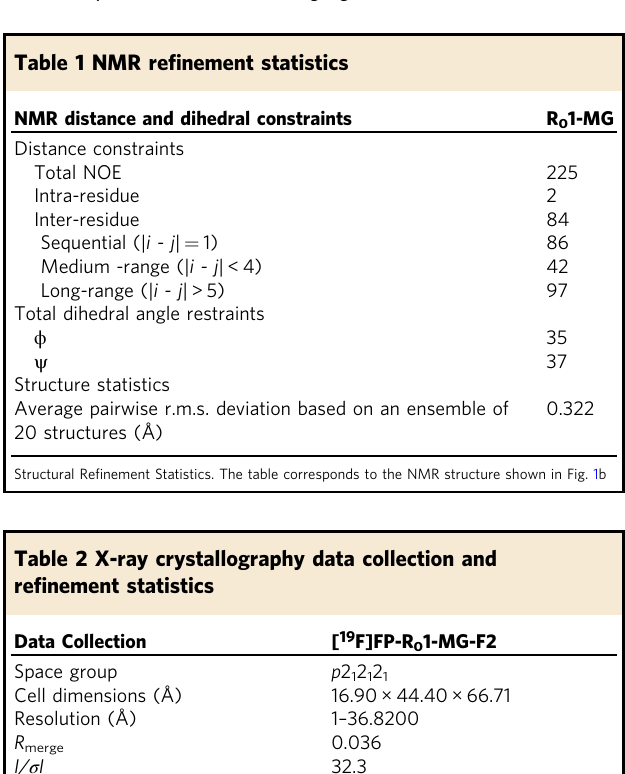
Fig. 8. The biodistribution of [ 18 F]FDG and [ 18 F]FP-R 0 1-MG-F2 at 1 h p.i. are compared in Supplementary Fig. 9.